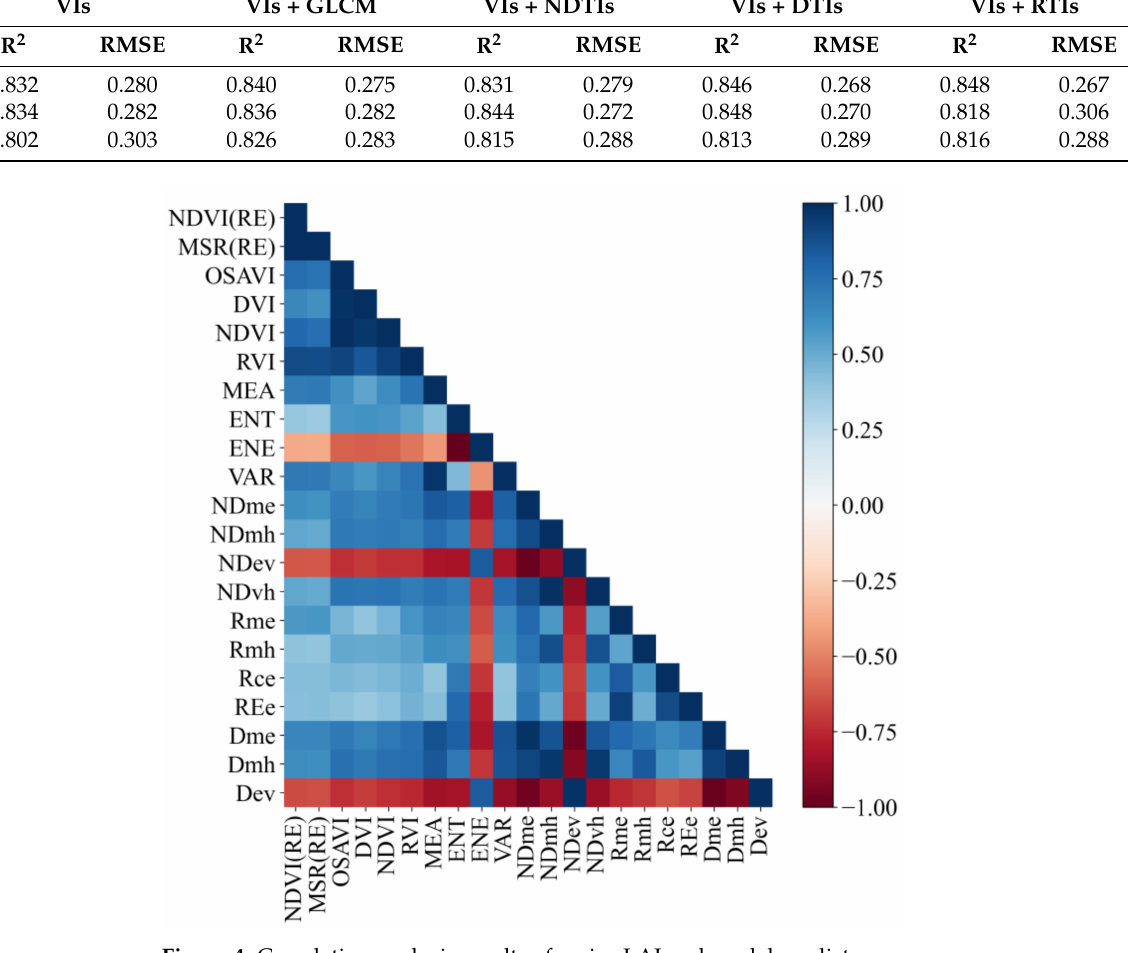
Figure 4. Correlation analysis results of maize LAI and model